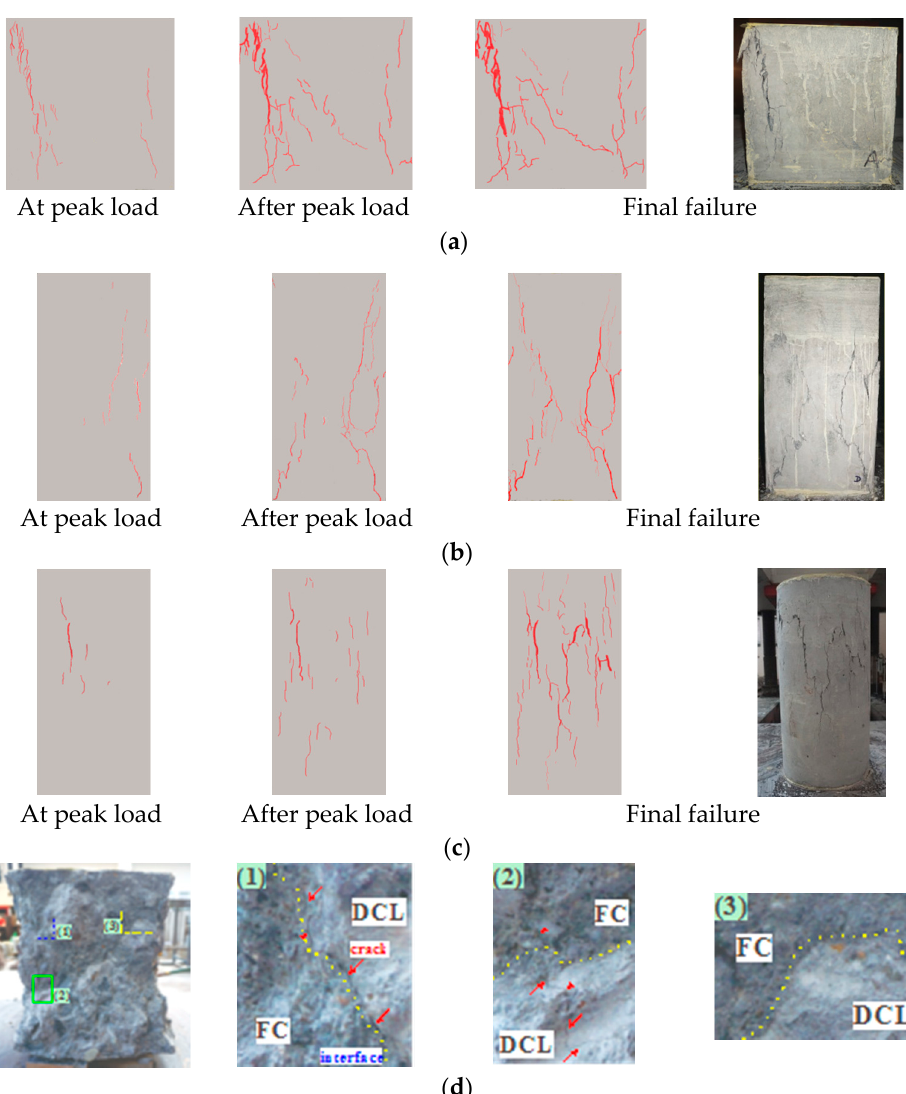
Figure 6. Concrete cracks and final failure patterns for three typical specimens: ( a ) specimen CU300-100-0.3; ( b ) specimen PR300-100-0.3; ( c ) specimen CY300-100-0.3; ( d ) bonding between DCLs and FC